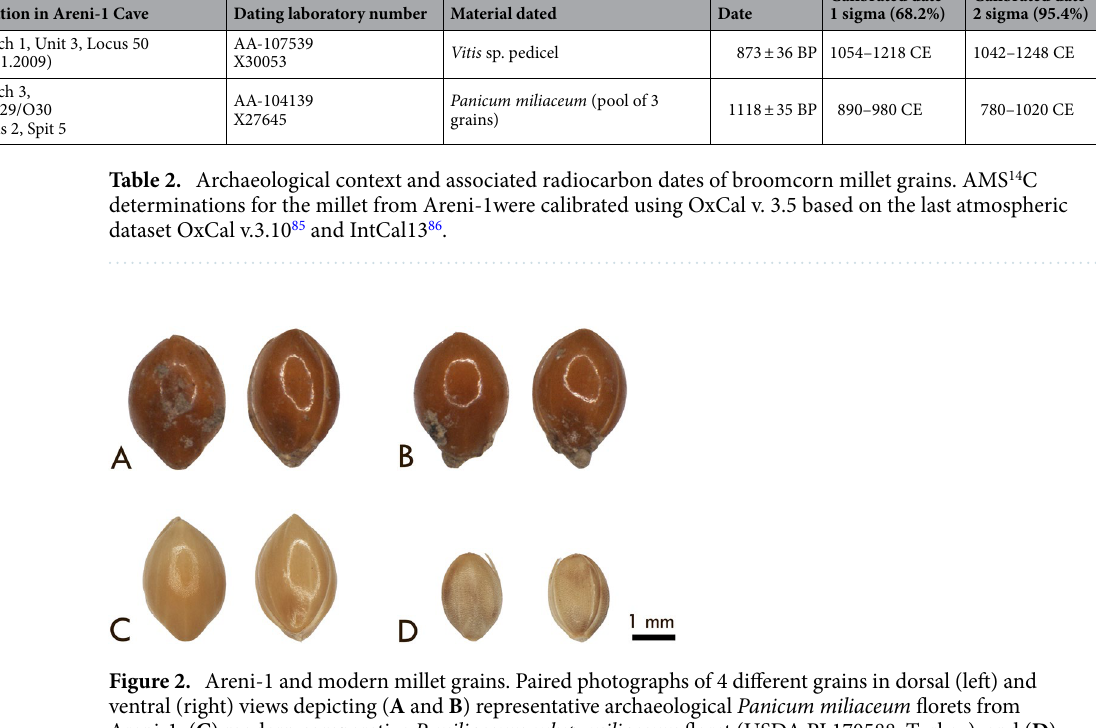
Sample Location in Areni-1 Cave